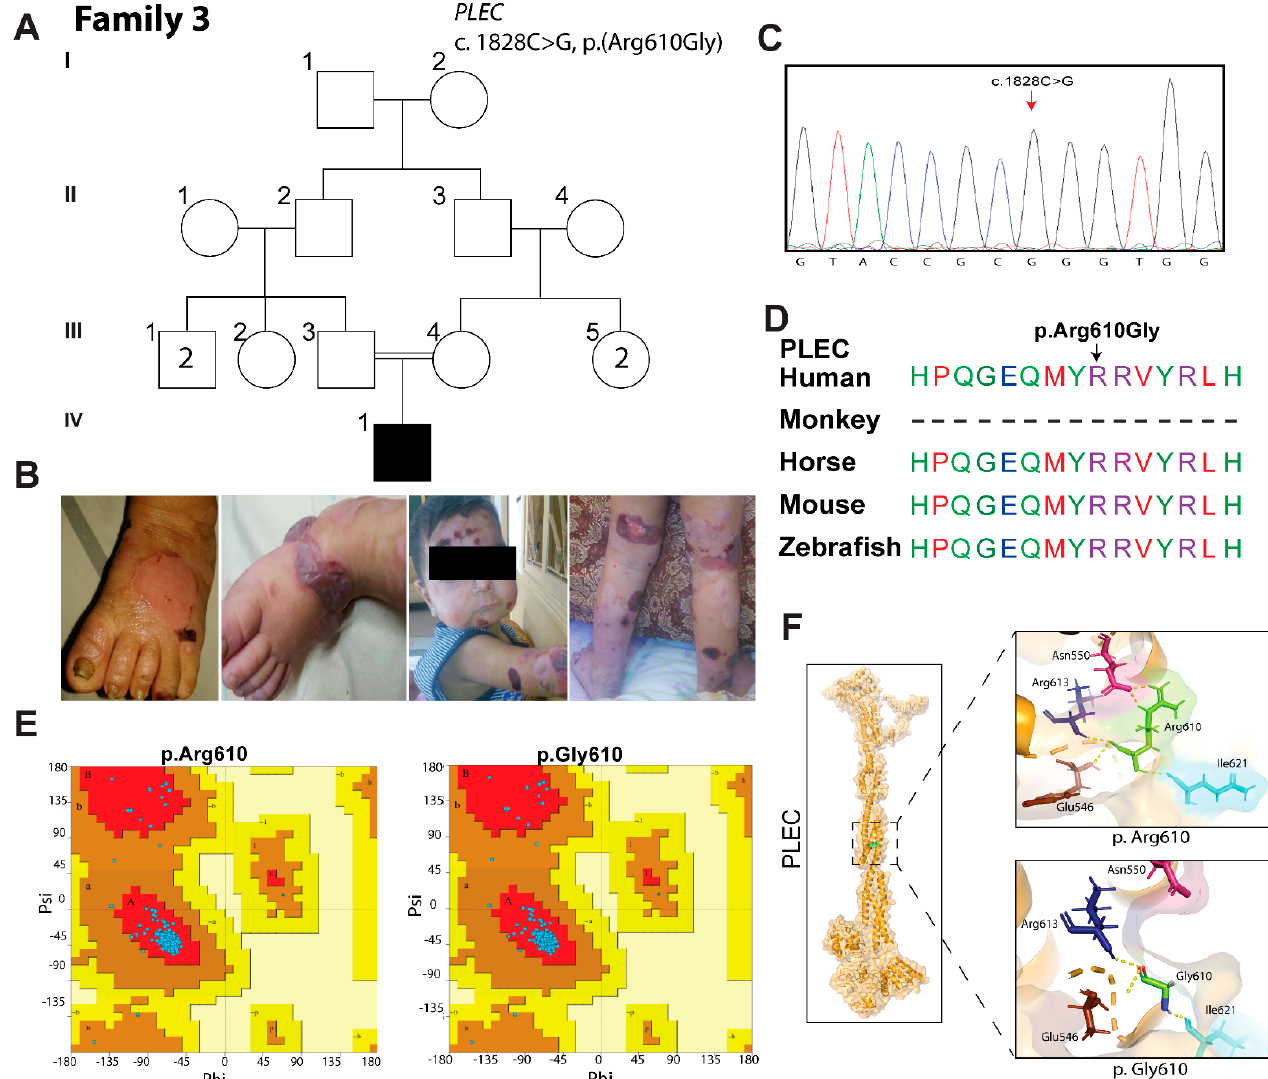
Figure 2 . EB phenotype in family 3 is associated with pathogenic variant of PLEC. ( A ) Pedigree of family 3. ( B ) Clinical features of enrolled patients showing cutaneous erosion, hemorrhagic crust and hypopigmented macules after rupturing of blisters, and nail dystrophy. ( C ) Chromatogram showing homozygosity in the patient (IV:1). ( D ) Clustal omega multiple sequence alignment showing conservation of arginine residue across different species ( E ) Ramachandran plot of wild-type and mutated protein reveals 98.6% residues in the allowed region; there is thus no significant impact on the stereochemistry and geometry of the encoded protein due to the p.Arg610Gly change. ( F ) 3D protein modeling of PLEC revealed a loss of ionic interactions (yellow dotted lines) with other residues in the core of the protein, due to the p.Arg610Gly variant.